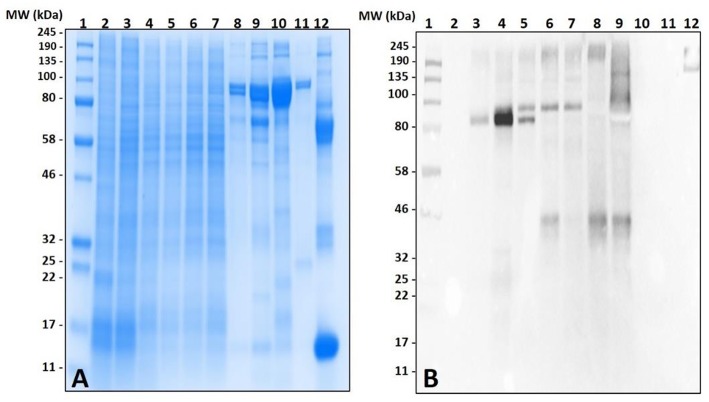
Identification of α-gal in the salivary glands of Amblyomma americanum during the blood meal. The unfed and partially-fed salivary glands from Am. americanum throughout the blood meal were analyzed, along with saliva from Am. americanum and Am. maculatum drooled with pilocarpine and dopamine. (A) SDS-PAGE using Any kDa Mini-PROTEAN TGX gel, (B) western blot using anti-gal IgM antibody. Lane 1, A broad range (11–245 kDa) pre-stained protein standard; Lane 2, Am. americanum unfed salivary glands; Lane 3, Am. americanum 1D partially-fed salivary glands; Lane 4, Am. americanum 3D partially-fed salivary glands; Lane 5, Am. americanum 5D partially-fed salivary glands; Lane 6, Am. americanum 7D partially-fed salivary glands; Lane 7, Am. americanum 8D partially-fed salivary glands; Lane 8, Am. americanum saliva (dopamine); Lane 9, Am. americanum saliva (pilocarpine); Lane 10, Am. maculatum saliva (pilocarpine); Lane 11, Am. maculatum saliva (dopamine); and Lane 12, Diluted bovine blood.